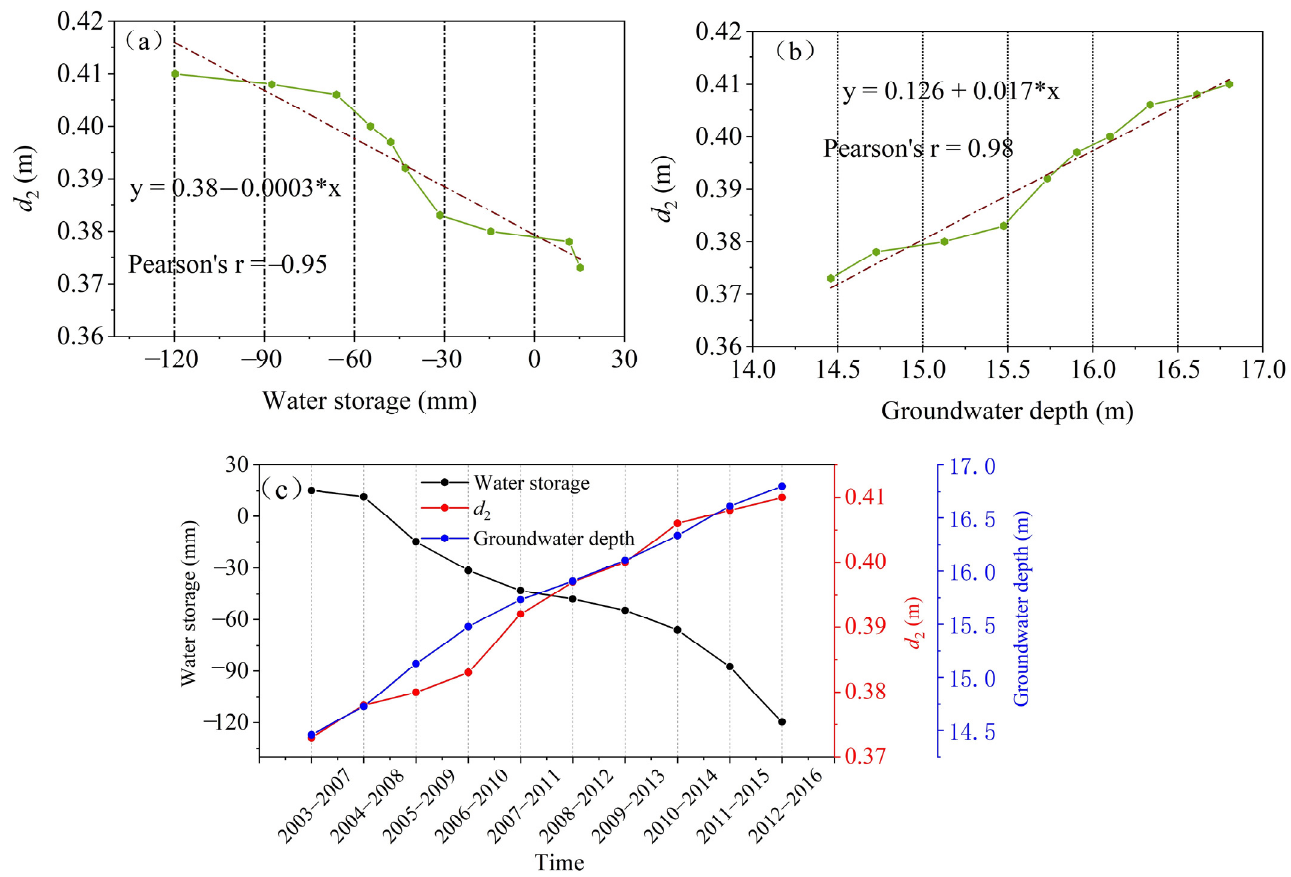
Figure 9. Correlation analysis of water storage, groundwater table depth, and the parameter d 2 ( a , b ), together with their variation trends for different sliding periods ( c ).